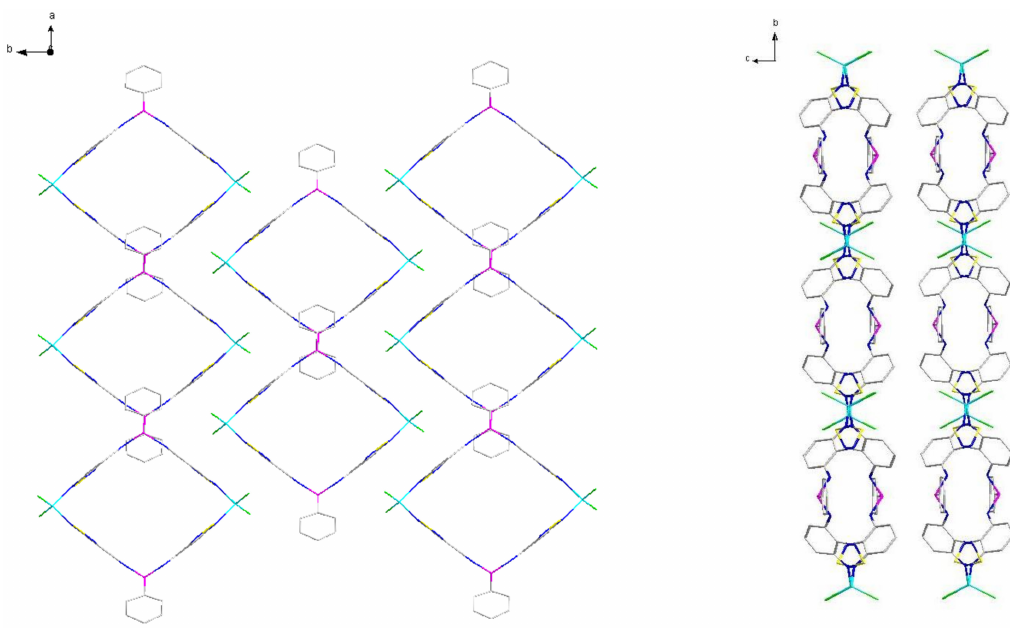
Figure 7. Crystal packing for 2a · 3C 7 H 8 . Hydrogen atoms and solvate molecules are not